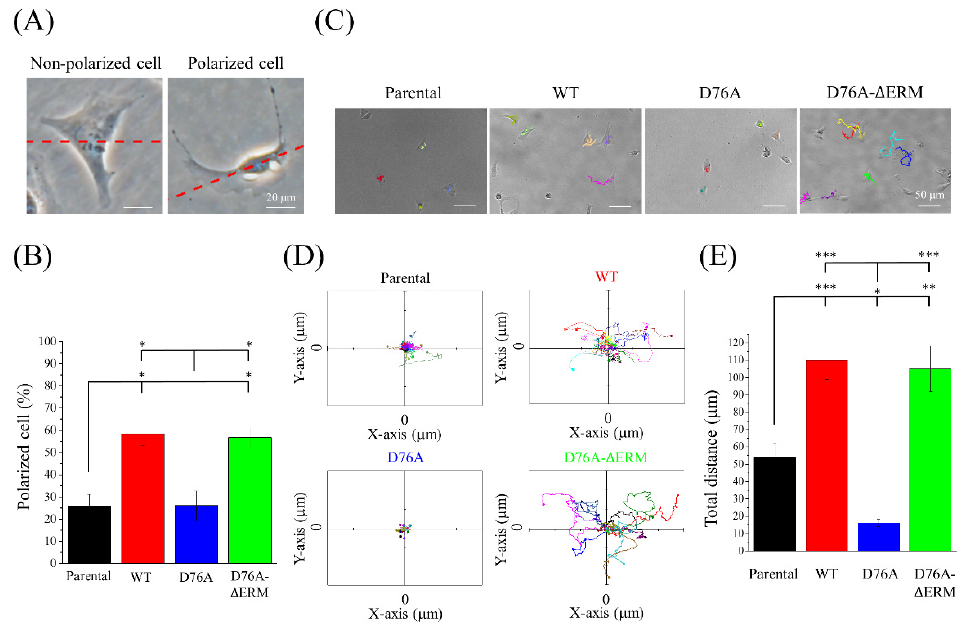
Figure 3. Impact of STIM1 variants on cell migration. ( A ) Phase contrast images showed the morphology of non-polarized and polarized cells. The extended lamellipodium at on side was displayed in polarized cells. ( B ) Quantification of polarized cell percentage under different STIM1 variant-expressed cells. Bars represent the mean ± SEM. ( C ) Migration trace of cells expressing different STIM1 variants was observed for 4 h by the mini-imaging system. The pictures were taken every 20 s. Representative images taken at 4 h were shown. Each cell was marked with a different color and at least 25 cells were recorded. ( D ) Trajectory images were obtained from the time-lapse images recorded in ( C ). Start position was set to 0. Each color represented the trace of a single cell. ( E ) Quantification of total distance from the time-lapse recording images. Bars represent the mean ± SEM. * p < 0.05, ** p < 0.01, *** p < 0.001 by one-way ANOVA.